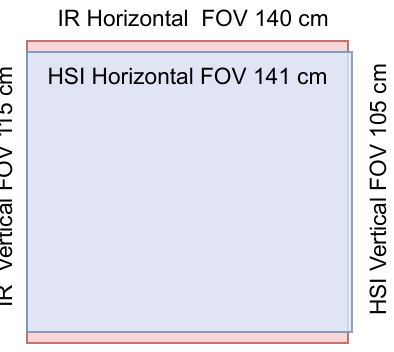
Figure 4. The hyperspectral camera lens provided a relatively similar vertical and horizontal field of views (visualized in blue) than the Kinect V2, which is visualized using red